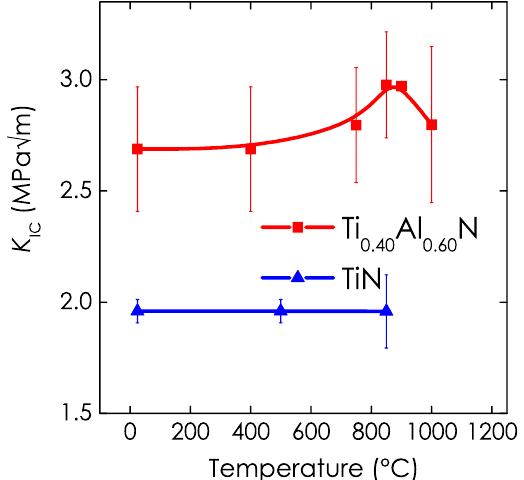
Figure 5. An increase in fracture toughness, K IC , is observed after 10 min vacuum annealing of the coatings at 850 and 900 °C (red curve). Such temperatures are typically reached in the application due to the friction between the coated cutting tool and the workpiece. In the case of TiN, where (spinodal) decomposition is absent, K IC remains roughly constant when heated above the film deposition temperature.